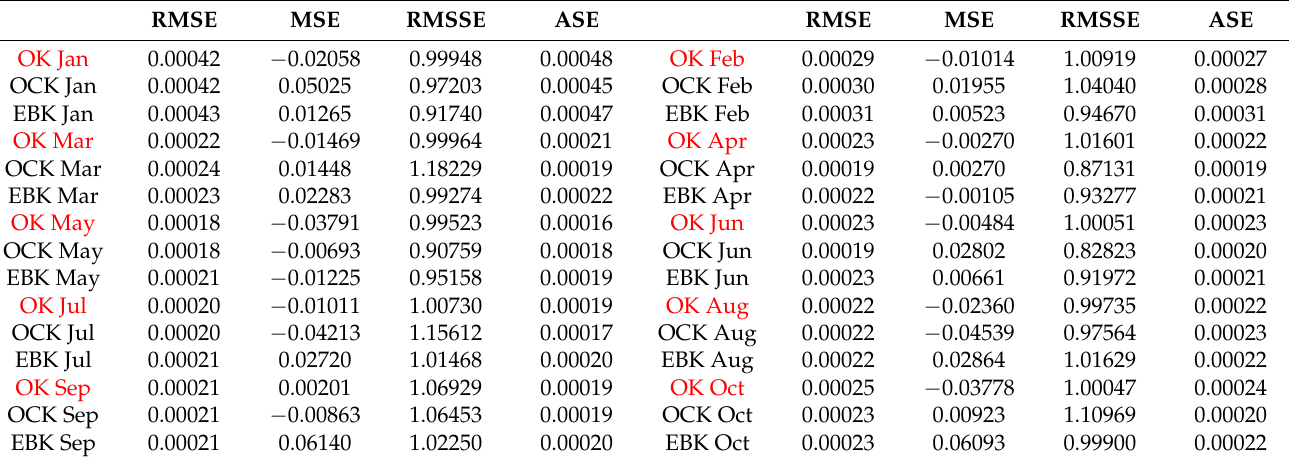
Table 7. Empirical coefficient of Hargreaves HC for each interval (Jan, Feb, Mar, etc.) multiplied by 10 − 3 , adapted to